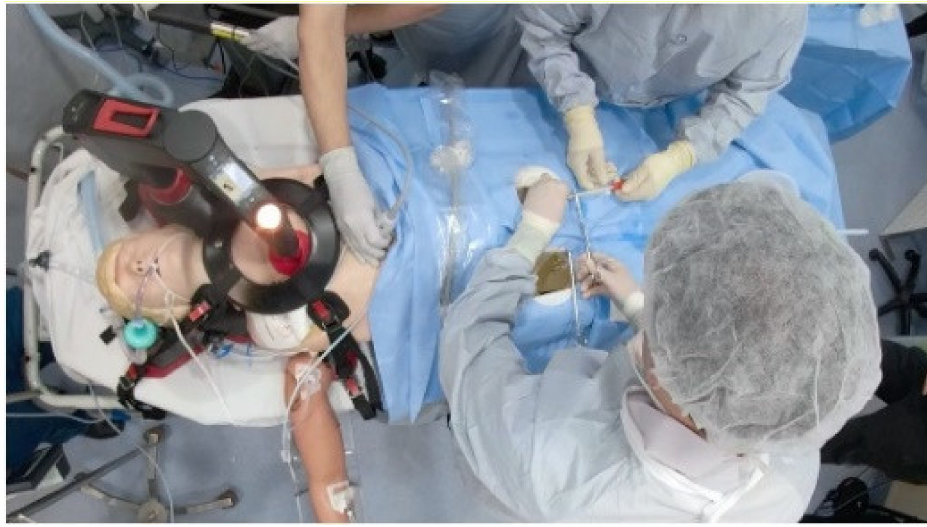
Figure 9. 3D-printed ECMO cannulation simulator